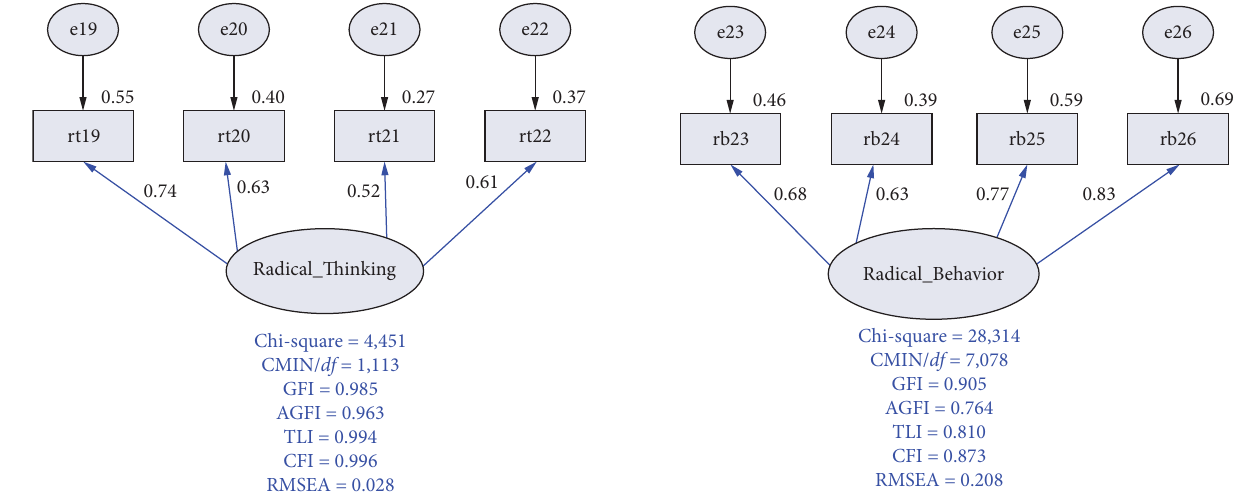
F IGURE 6: Diagram and output of AMOS 24 application for radical behavior dimension.